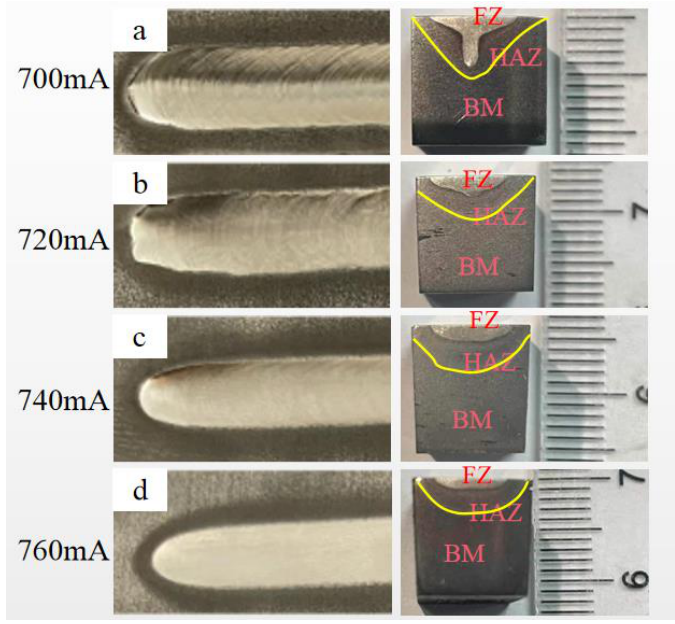
Figure 2. Surface morphology of Inconel 625 nickel-base alloy after electron beam surface strengthening with different process parameters: ( a ) 700 mA, ( b ) 720 mA, ( c ) 740 mA, ( d ) 760 mA.